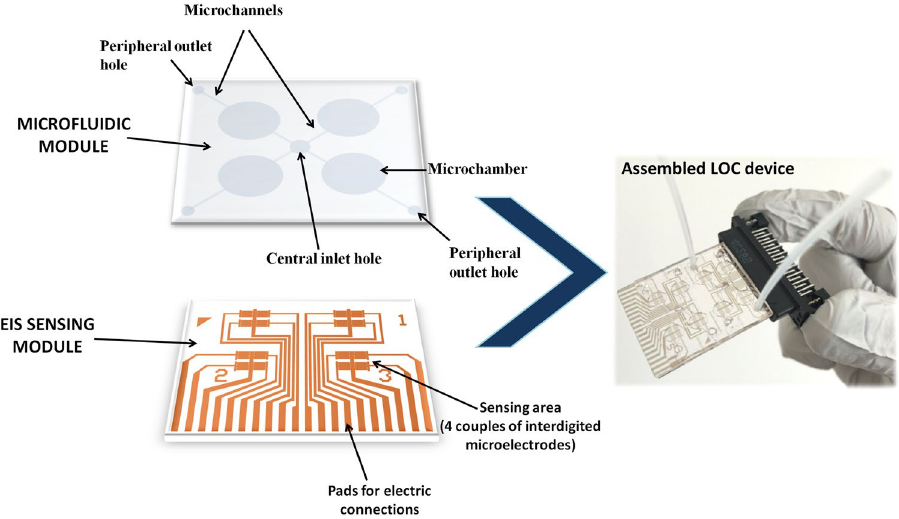
Figure 2. Description of the LOC device for the detection of Xylella fastidiosa made up of a sensing and a microfluidic